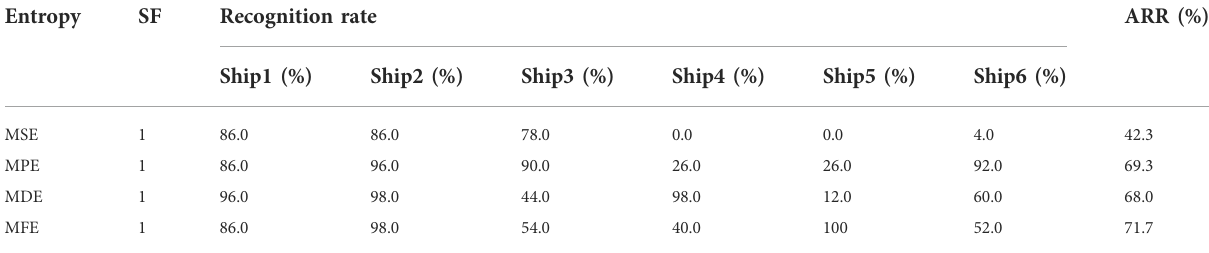
TABLE 4 Highest ARR of a single